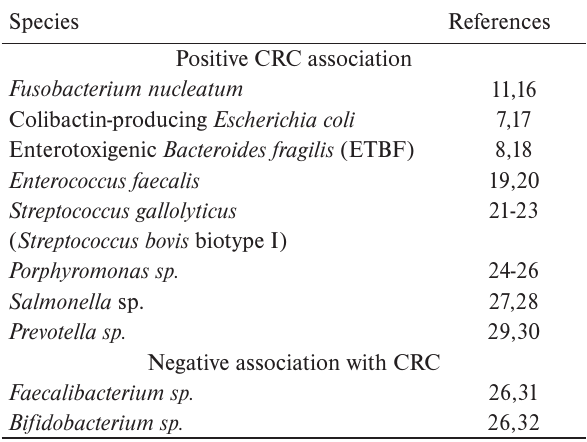
Table 1. Bacterial species positively or negatively associated with colorectal cancer.